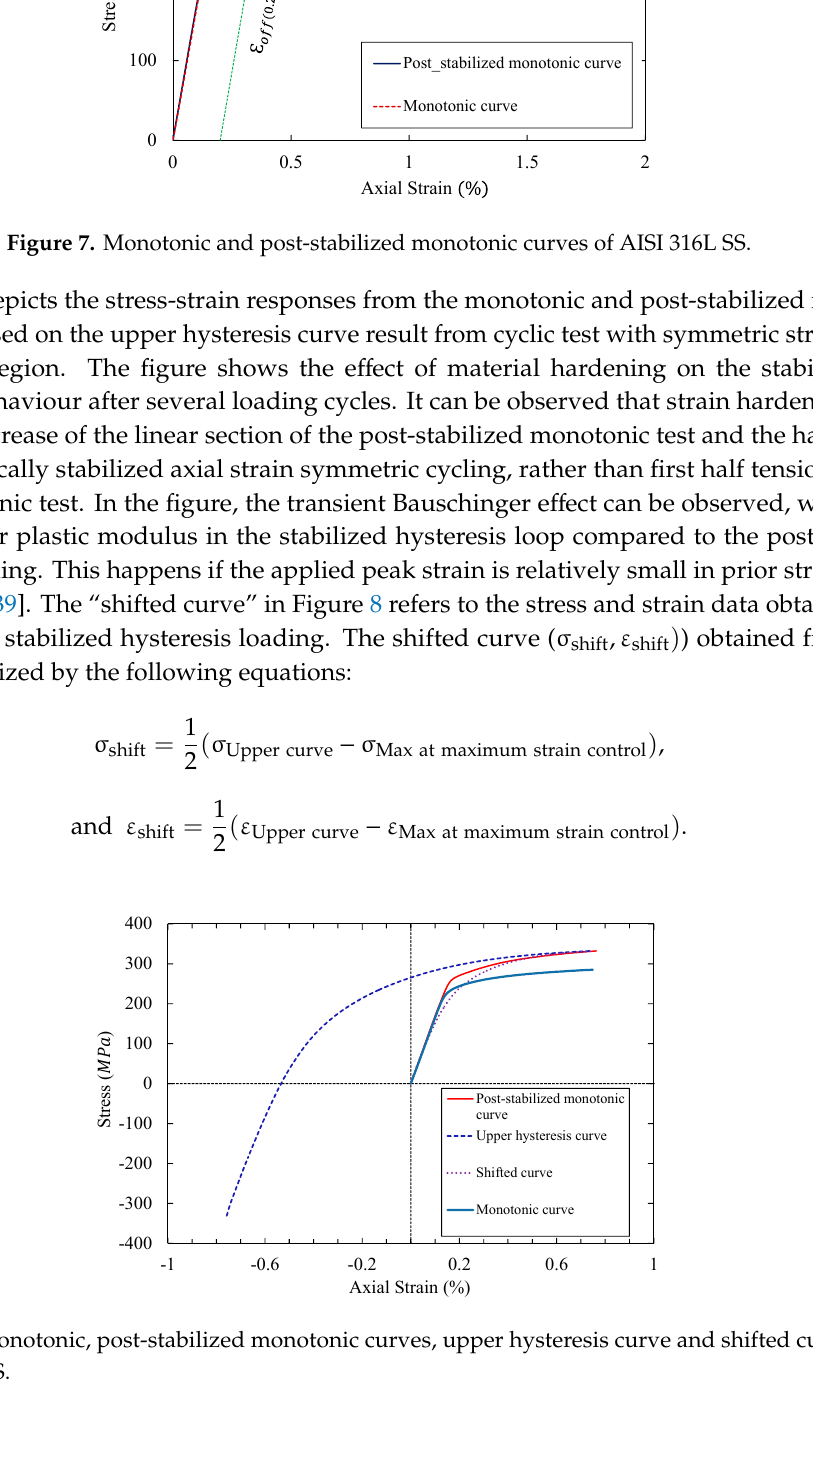
Figure 6. ( a ) Cyclic hardening behaviour of 316L stainless steel ( b ) stabilized hysteresis curve.